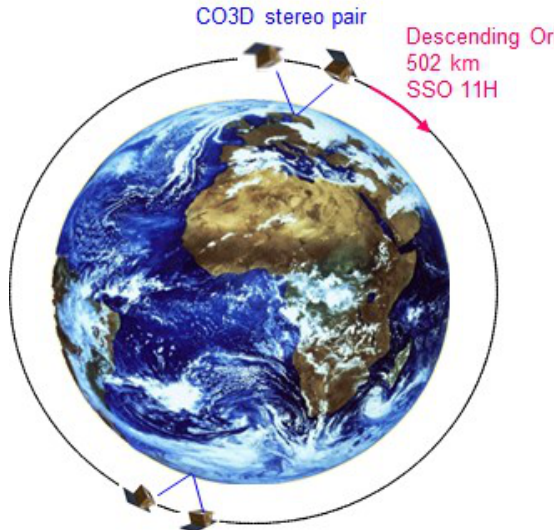
Figure 3. CO3D orbital configuration for 4 satellites